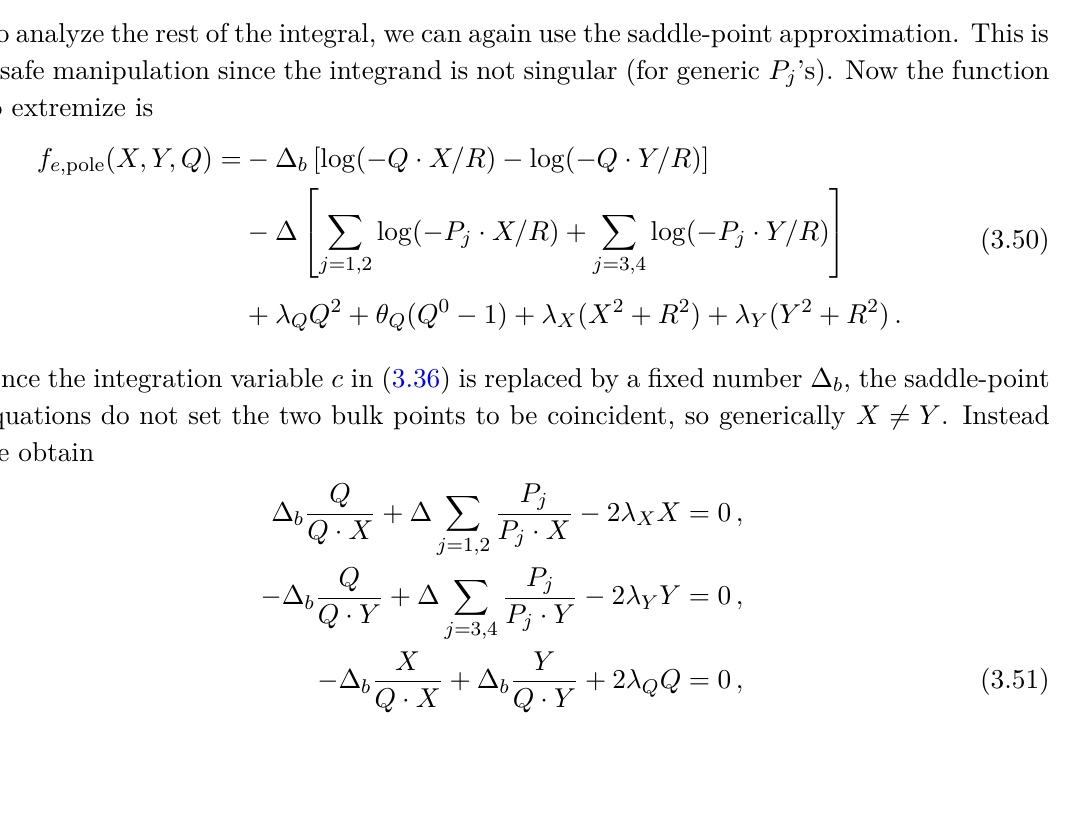
Figure 9. The contributions from the saddle point and the pole for the exchange diagram. To evaluate the exchange diagram using the saddle-point approximation of the c -integral, we need to deform the original contour (the red dashed line) to a steepest descent contour (the solid red line) that goes through the saddle point (the blue dot). Upon doing so, the contour sometimes needs to cross the poles of the integrand and this produces an additional contribution. Physically, the contribution from the saddle-point corresponds to a scattering process in which the four-particles meet at a point while the contribution from the pole corresponds to a geodesic network. The former is related to a flat-space S-matrix while the latter is